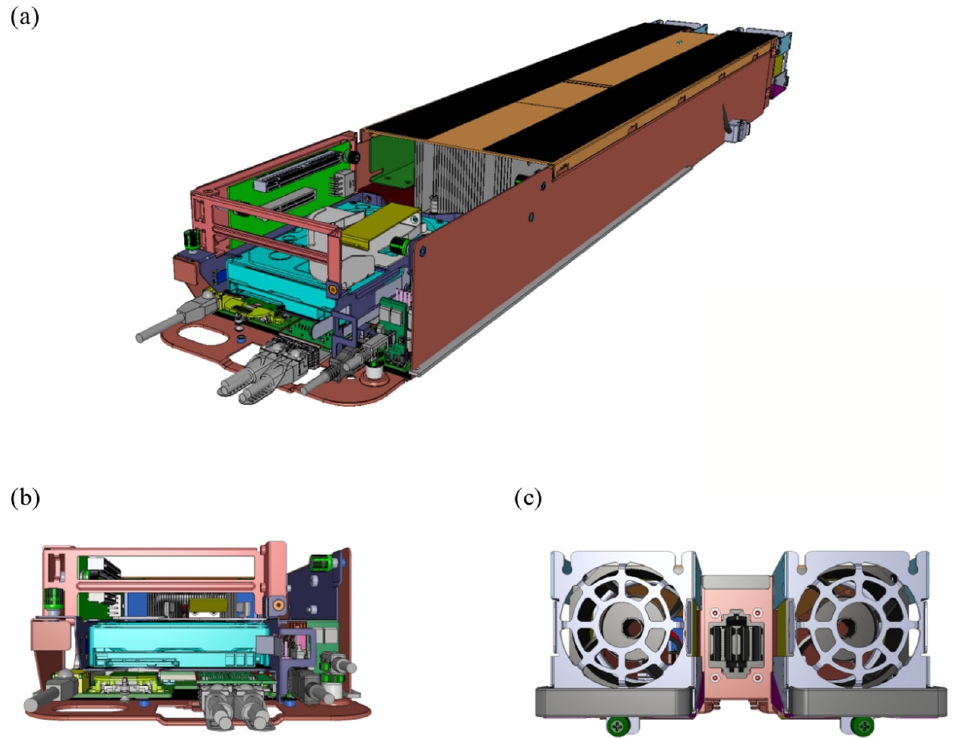
Figure 1. ( a ) Three-dimensional, ( b ) front and ( c ) back views of the Leopard V3.1 model of OCP server.